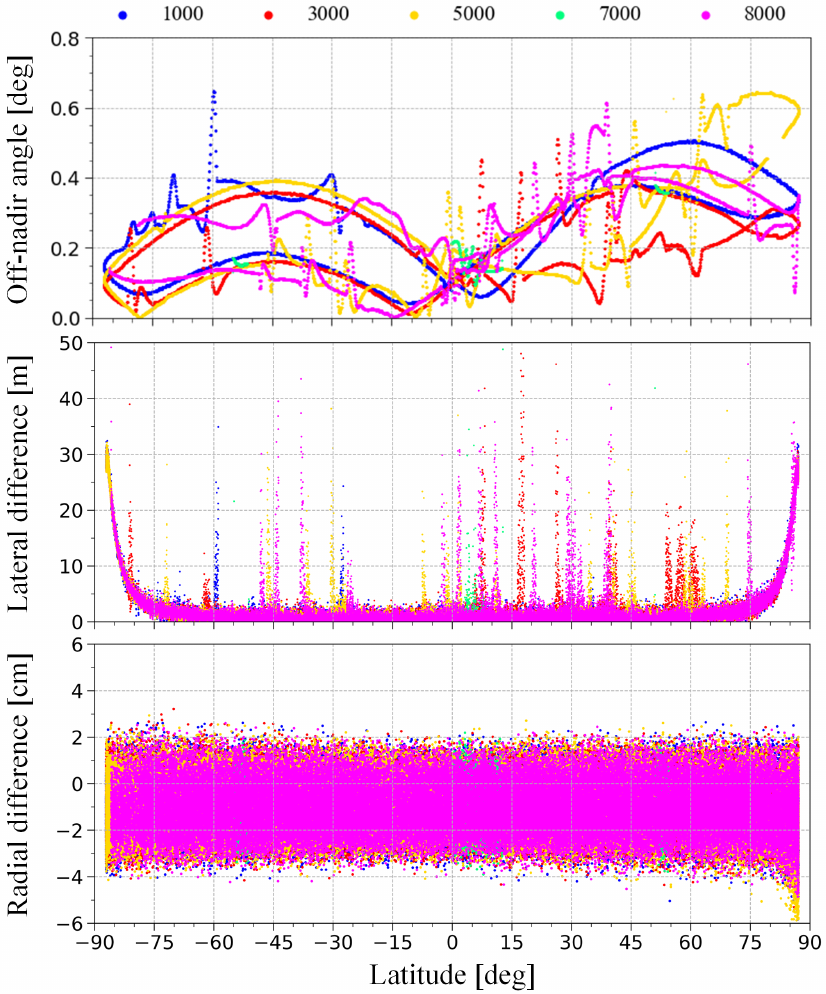
Figure 2. Off-nadir angles of the selected profiles as documented in the PEDR dataset ( top ). Lateral ( center ) and radial ( bottom ) residuals of SMM with Mars as the observer with respect to the PEDR. The lateral difference is treated as the geodetic distance along the IAU2015 Mars